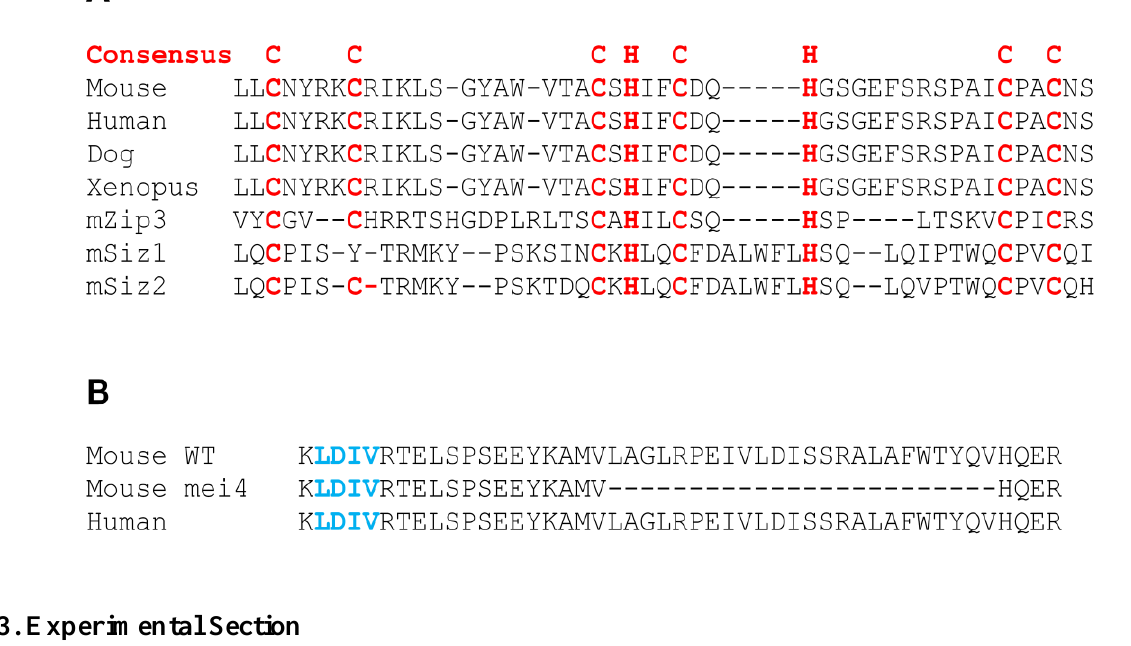
Figure 3. SUMO E3 ligase-like domain conservation in CCNB1IP1. ( A ) Alignments of C3H2C3-type RING domains in four CCNB1IP1 orthologs and other known SUMO E3 ligases; ( B ) CCNB1IP1 contains a canonical SIM motif (blue) just upstream of the